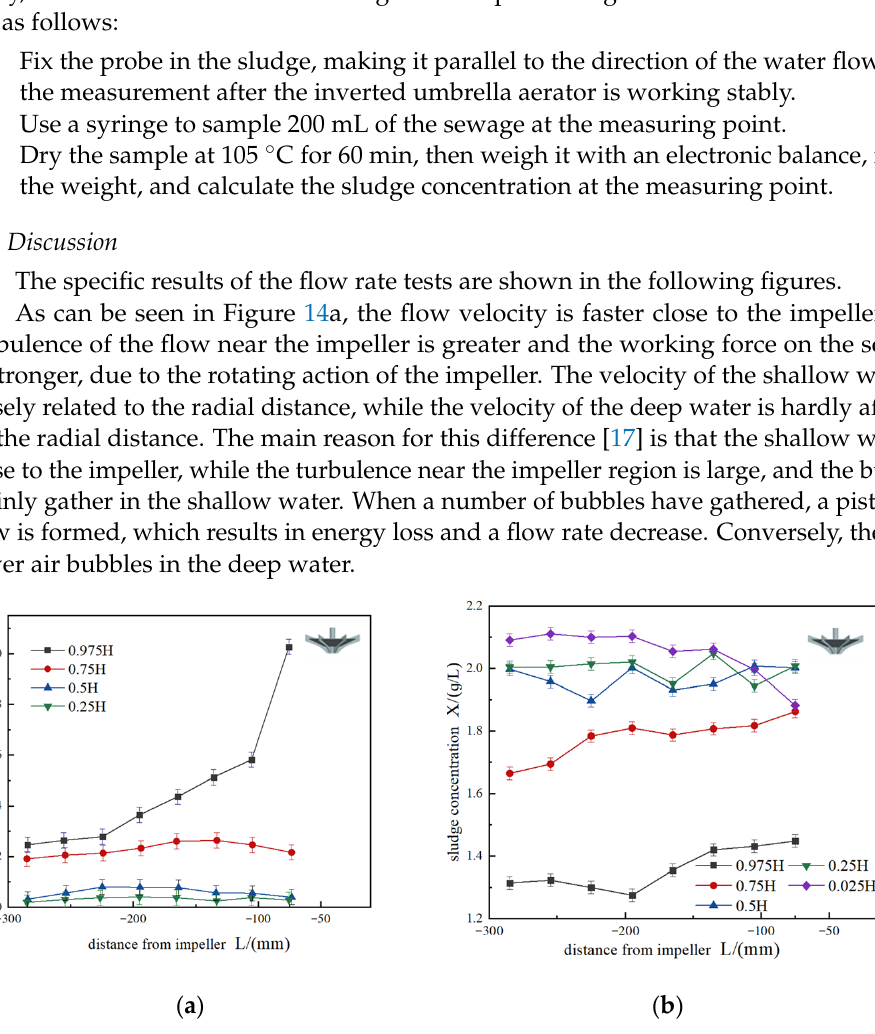
Figure 14. ( a ) The flow rate of each measuring point. ( b ) The sludge concentration at each measuring point.